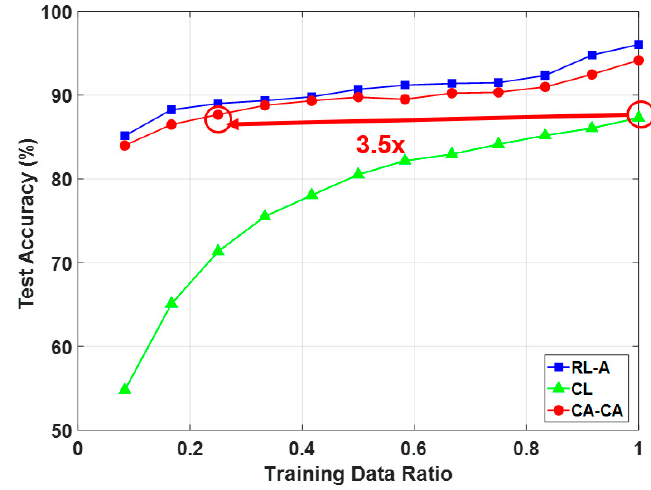
Figure 13. Comparison of classification accuracy under a different number of training data.